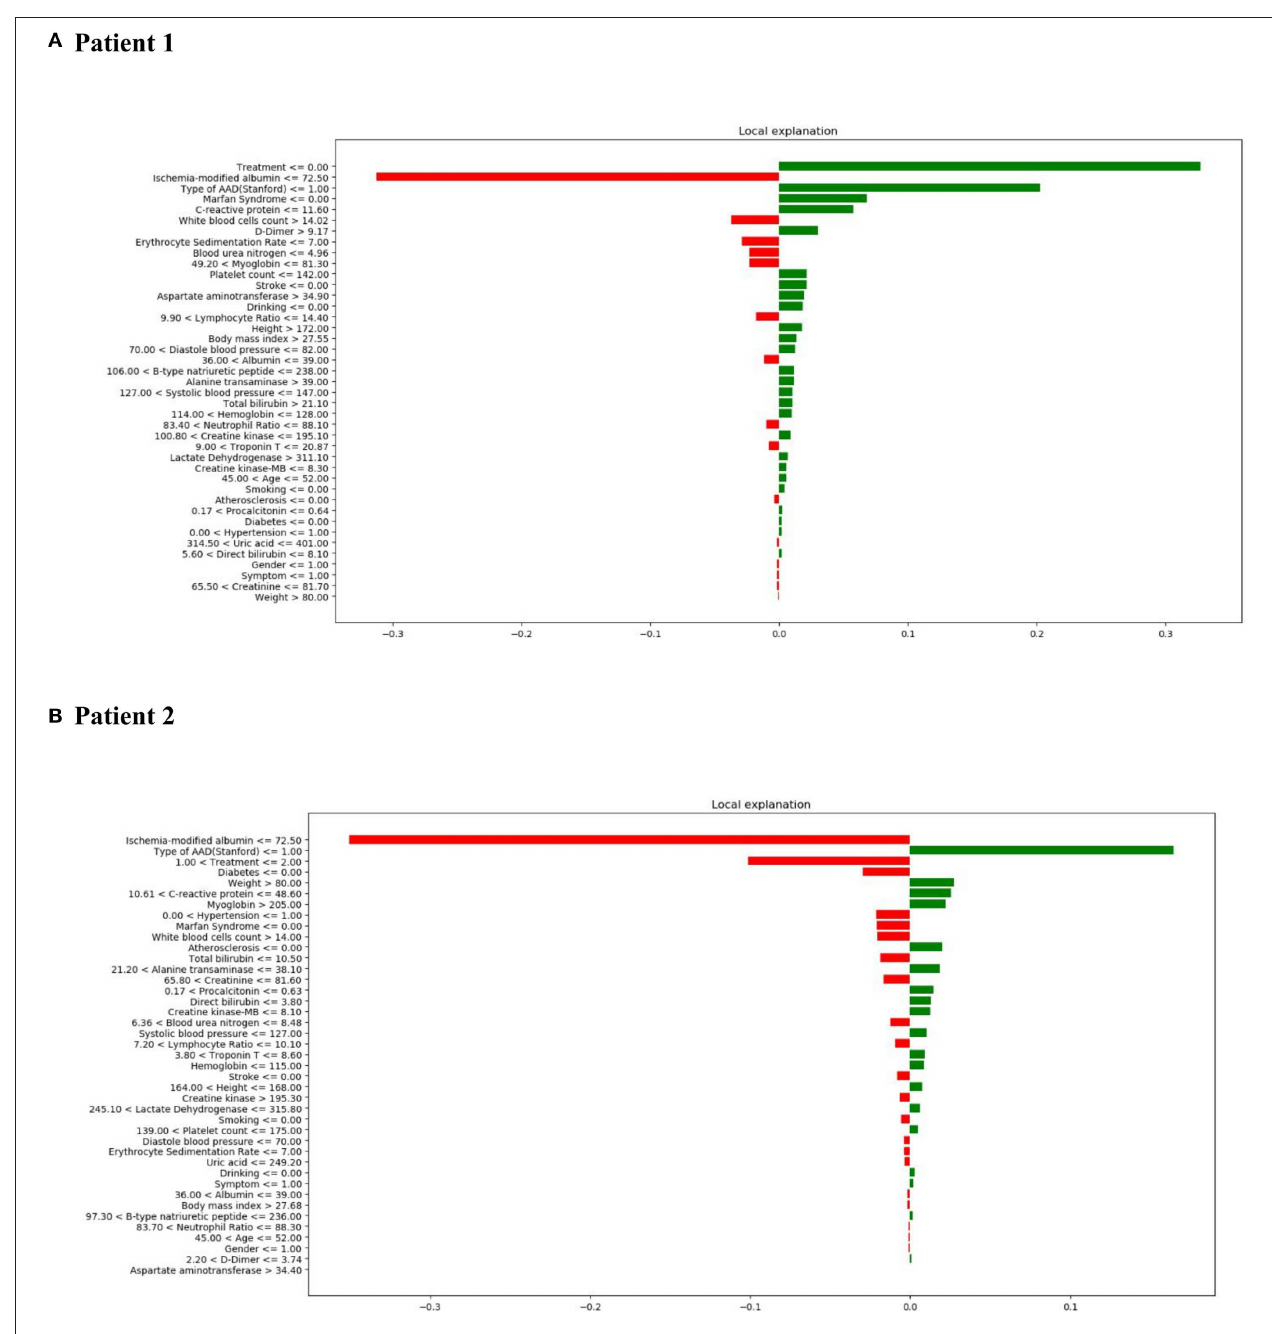
FIGURE 7 | LIME results with XGBoost classifiers used for two patients with correct predictions (one true positive [in-hospital mortality] patient and one true negative [survival] patient). The contribution of various features to the likelihood of in-hospital mortality are shown for each patient. Each column illustrates the contributions of the features to the probability included in the models. Green represents a positive contribution and red represents a negative contribution. Below the feature, the depicted value signifies the weight coefficient provided by LIME, which is linked to the feature’s contribution to the model prediction. (A) LIME explanation for true positive patient 1; (B) LIME explanation for true negative patient